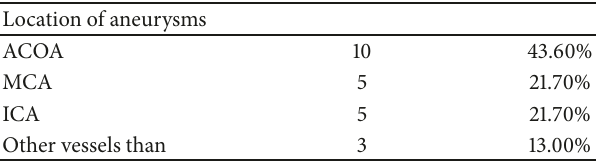
Table 4: Distribution of intracranial aneurysms.